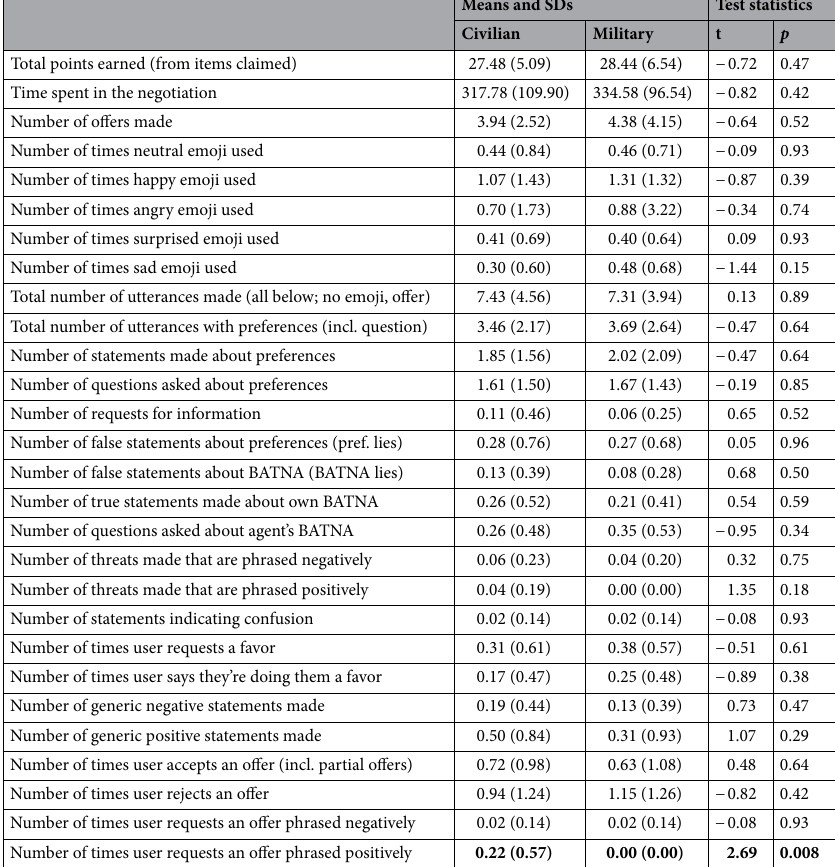
Table 1. Means and standard deviations for experimental conditions with T Value for the comparison. Significant values are in